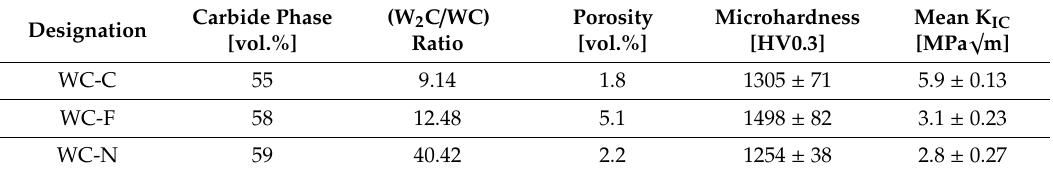
Table 3. Microstructural and mechanical properties of the HVOF coatings investigated by Nahvi et al.